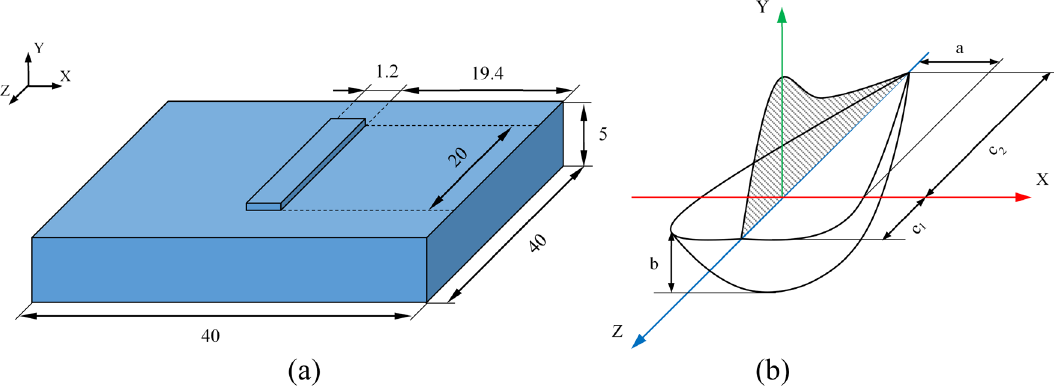
Figure 1. ( a ) The geometry of the single-layer deposition (mm). The deposition thickness was considered 0.8 mm according to the results obtained in experimental evaluations. ( b ) The double ellipsoidal heat source model and its